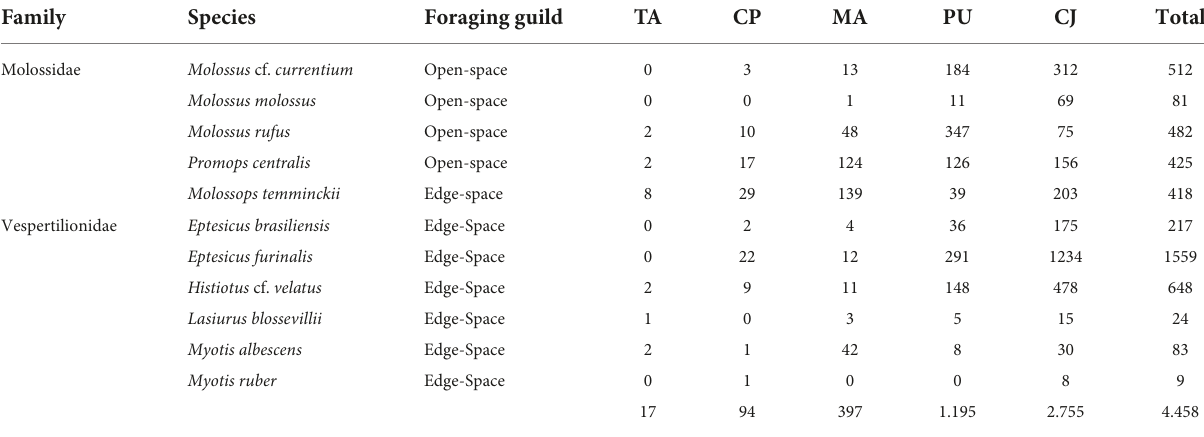
TABLE 2 Total number of bat passes in each of the five sampled areas, and information on species, family, and foraging guild, regarding bat acoustic sampling during spring and summer 2019 and 2020 in the Brazilian Pampa. Family Species Foraging guild TA